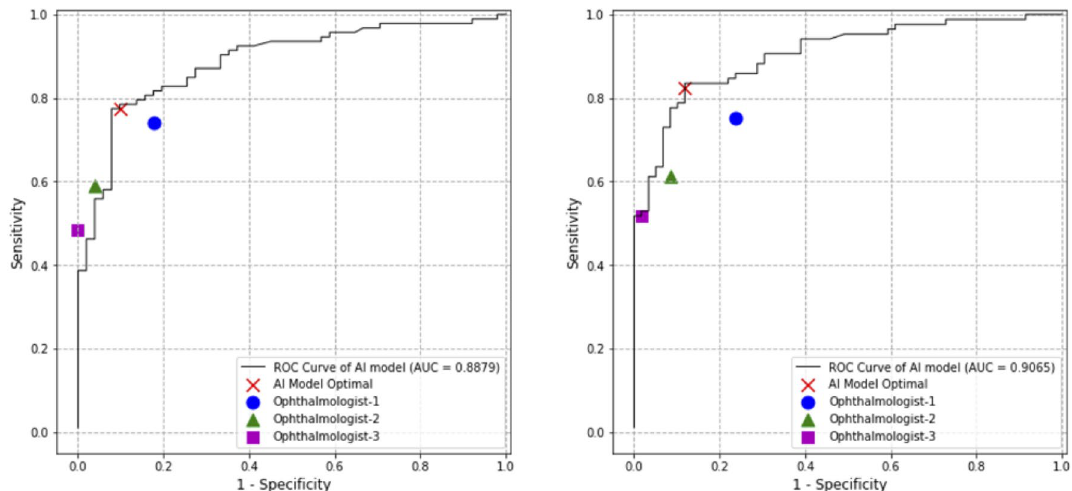
Figure 6. Receiver operating characteristic curve using comprehensive diagnosis as standard diagnosis. Operation points of manual diagnosis were illustrated on the graph, in order to compare the performance between ophthalmologists and AI model. AUC areas under the